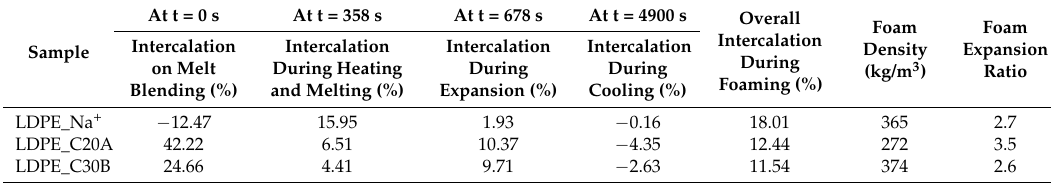
Table 4. Intercalation on melt blending, foaming, and overall intercalation degree, final foam densities, and foam expansion ratios achieved with the different types of nanoclays in the materials based on